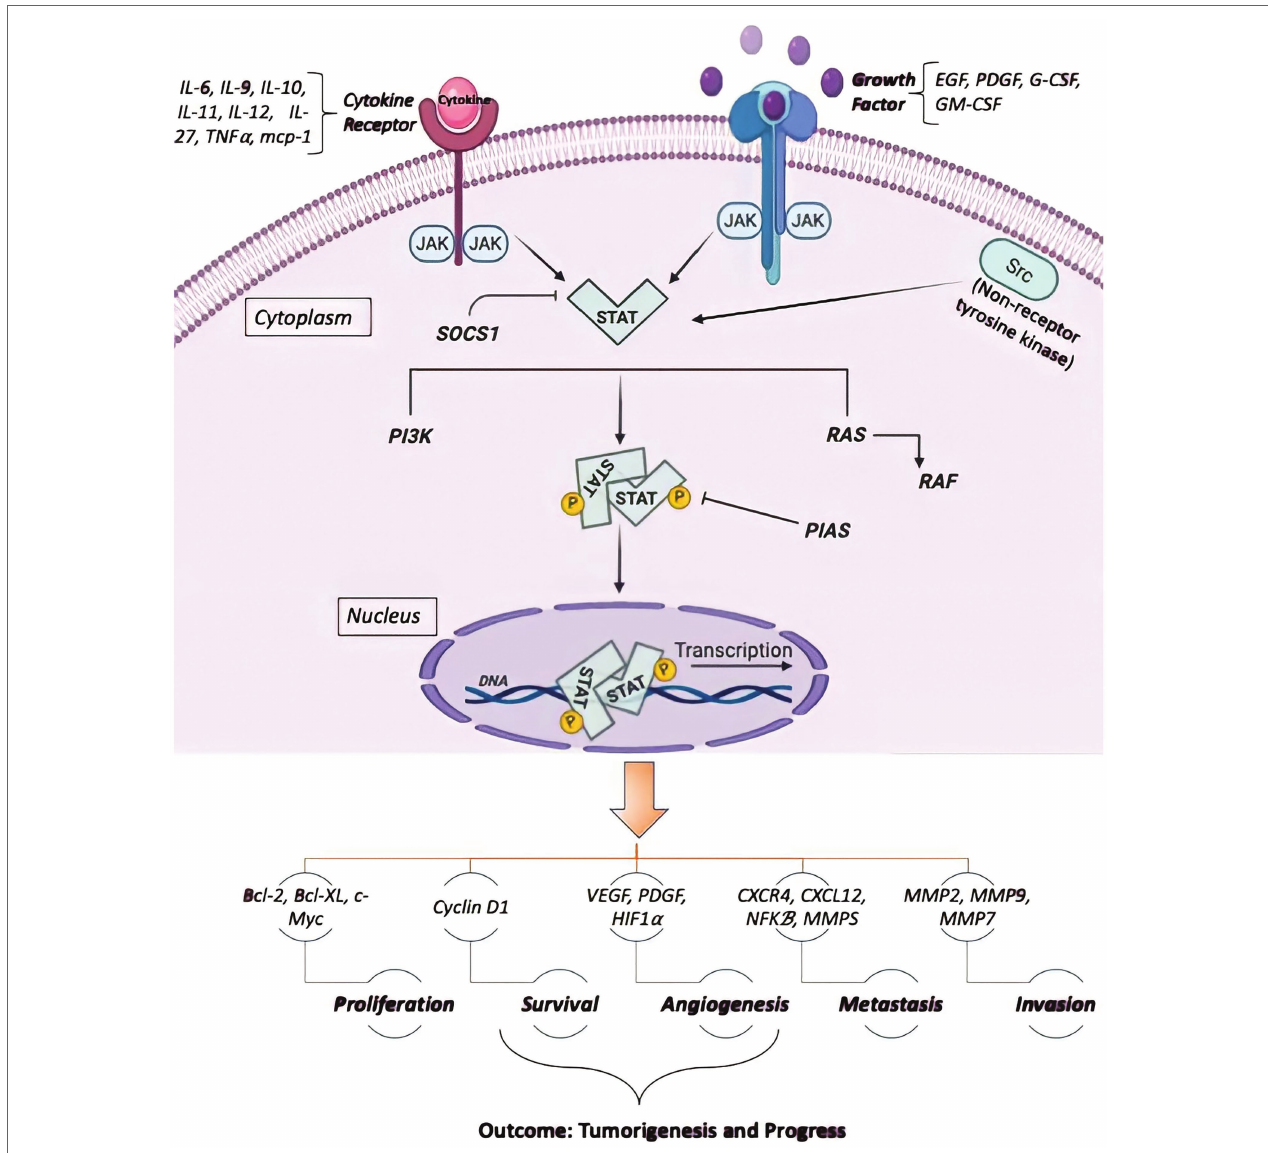
FIGURE 2 | The binding of different ligands to their receptors on the cell surface allows the STAT to be phosphorylated inside the cell and thus transferred to the nucleus for binding the target gene to the promoter region, activating transcription. It regulates cell proliferation and survival by controlling Cyclin D1, cMyc, BclXL, Mcl1, and p5, and also is involved in cell migration via the control of Rho and Rac. STAT also regulates the angiogenesis required for tumor growth and metastases via VEGF and